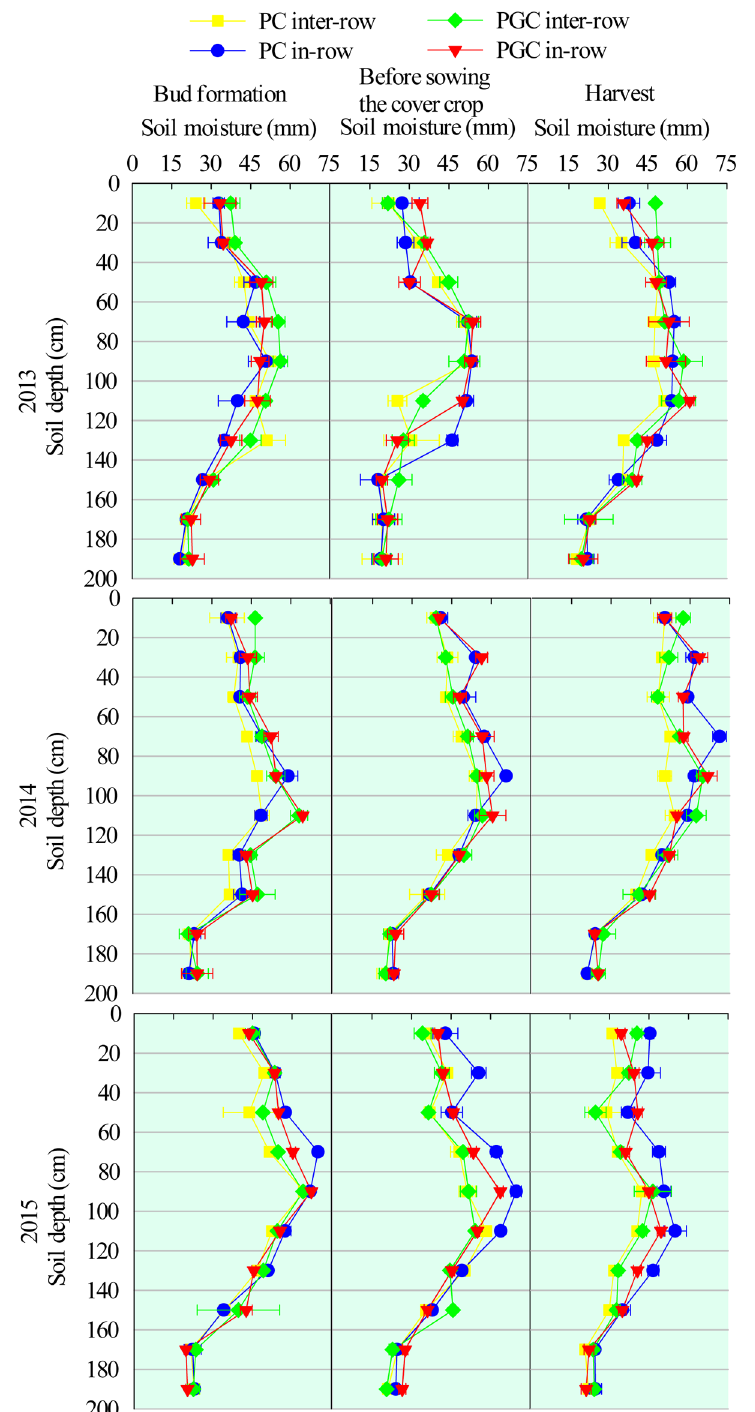
Fig 5. 0–200 cm soil moisture (layer by layer) in each treatment (inter-row and in-row) at different stages.